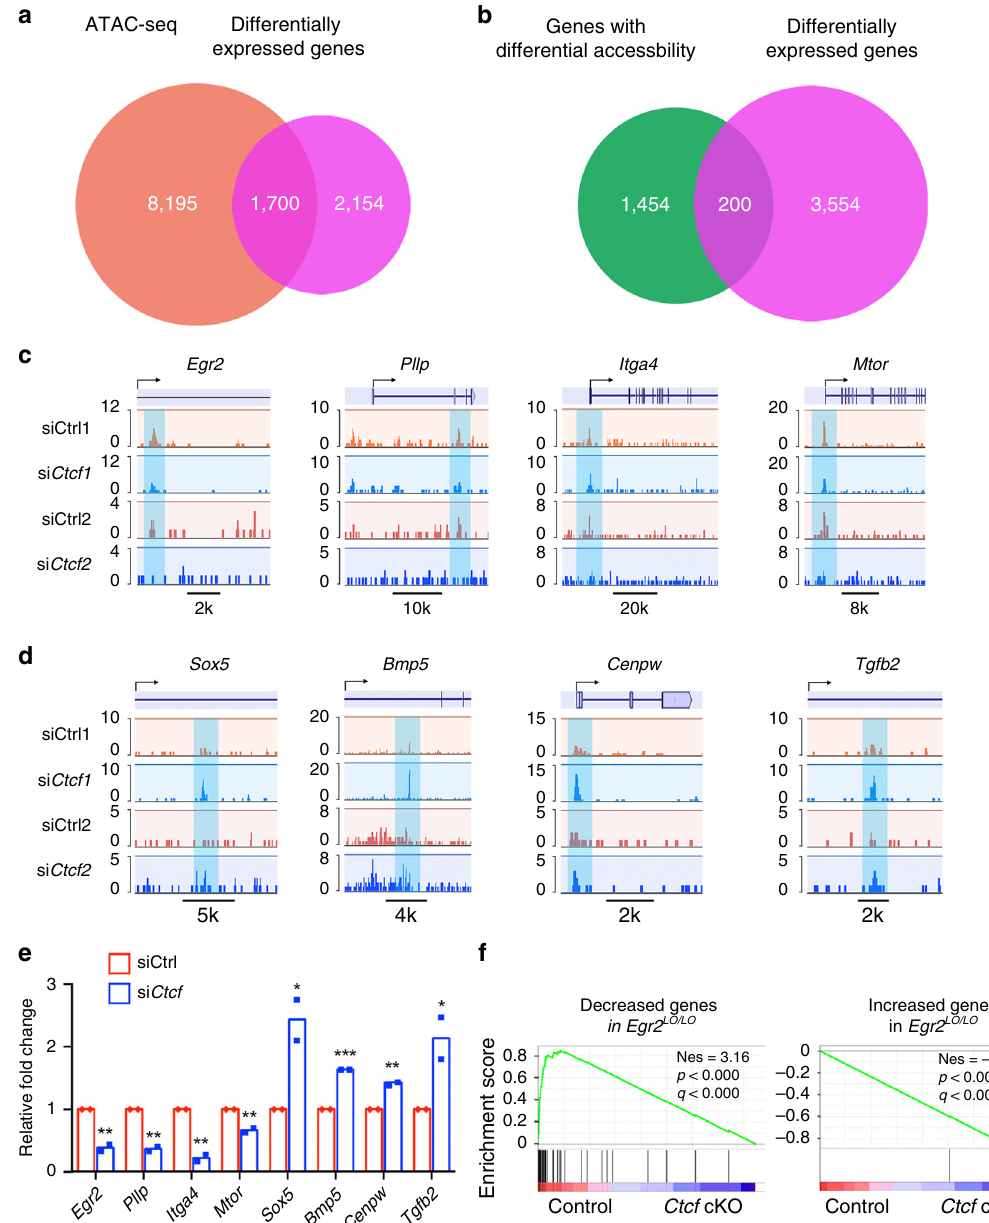
Fig. 7 CTCF regulates chromatin accessibility during SC differentiation. a , b Venn diagram showing the overlap between the genes located in open chromatin sites in rat SCs ( a ) or the genes with differential chromatin accessibility ( b ) by ATAC-seq with genes differentially expressed genes between control and Ctcf cKO sciatic nerves. c , d Representative ATAC-seq signals around the Egr2 MSE and myelination-related gene loci ( c ), as well as SC negative- or proliferation-related genes ( d ) in control or siCtcf -treated rat SCs, n = 2 biological replicates for control and si Ctcf SCs. e Relative fold-change of ATAC-seq peaks in panel c and d . n = 2 biological replicates for control and si Ctcf SCs. f GSEA enrichment scores for genes downregulated (left) or upregulated (right) genes in Egr2 Lo/Lo nerves from published data 34 . NES, normalized enrichment score. Data are presented as means ± SEM., * P < 0.05, ** P < 0.01, *** P < 0.001; one-tailed unpaired Student ’ s t -test, P (Egr2) = 0.0033, P (Pllp) = 0.0014, P (Itga4) = 0.0021, P (Mtor) = 0.0053, P (Sox5) = 0.024, P (Bmp) = 4E-07, P (Cenpw) = 0.0017, P (Tgfb2) = 0.039. Source data are provided as a Source Data fi